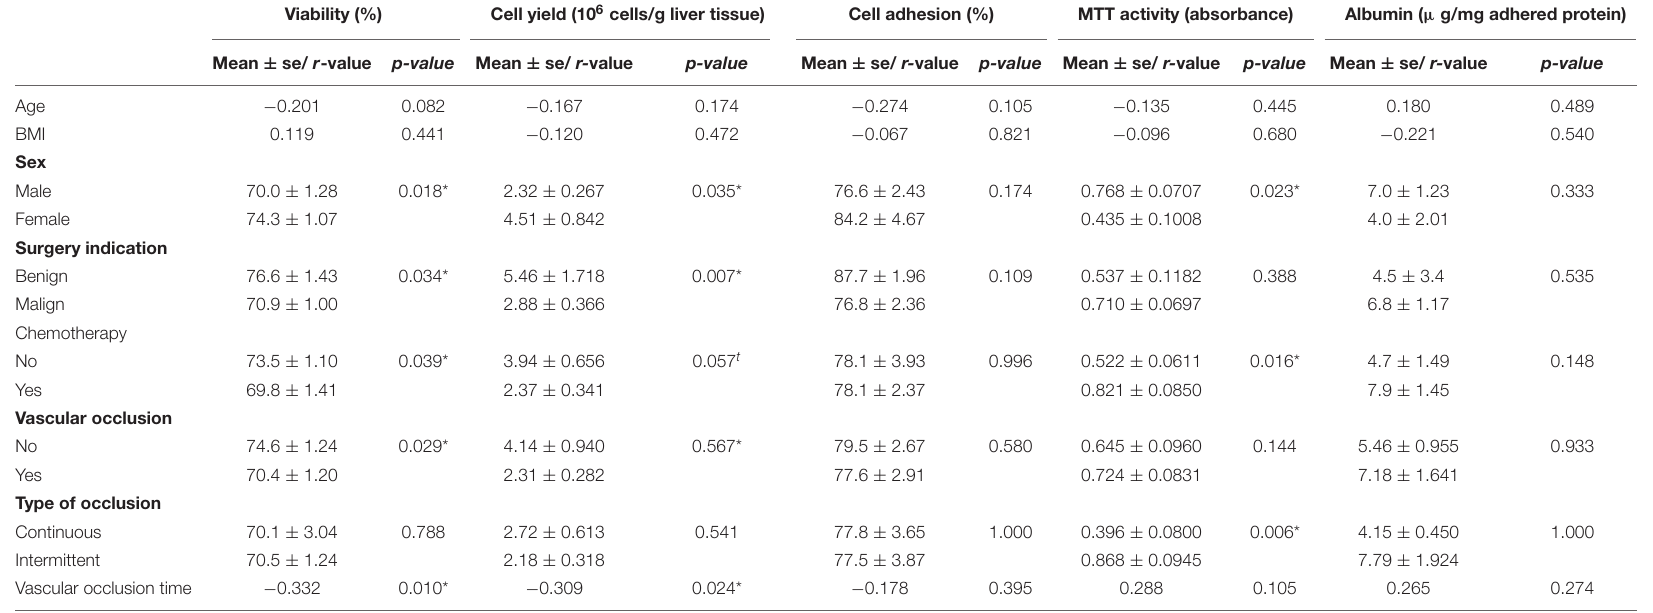
TABLE 2 | Effect of patient- and surgical-associated factors on isolated hepatocytes’ number, viability, and